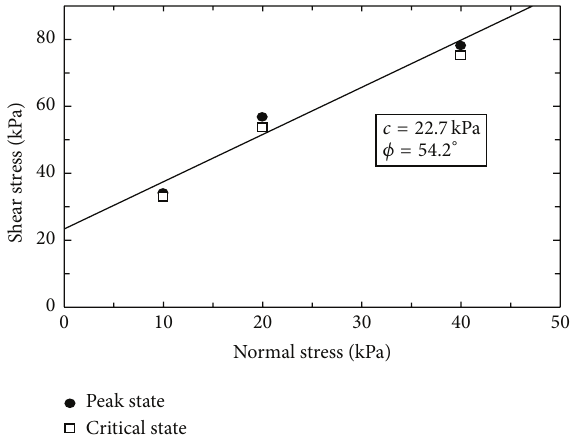
Figure 5: Shear strength failure envelope for unreinforced FG.